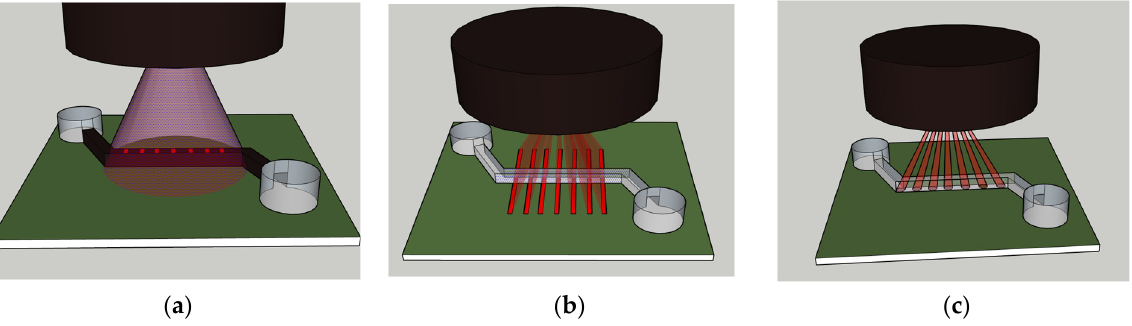
Figure 1. Top-down illumination for a simple optofluidic biosensor using: ( a ) A large laser spot through windows in the fluid channel; ( b ) a pattern of laser lines over the fluid channel; ( c ) a pattern of laser spots.